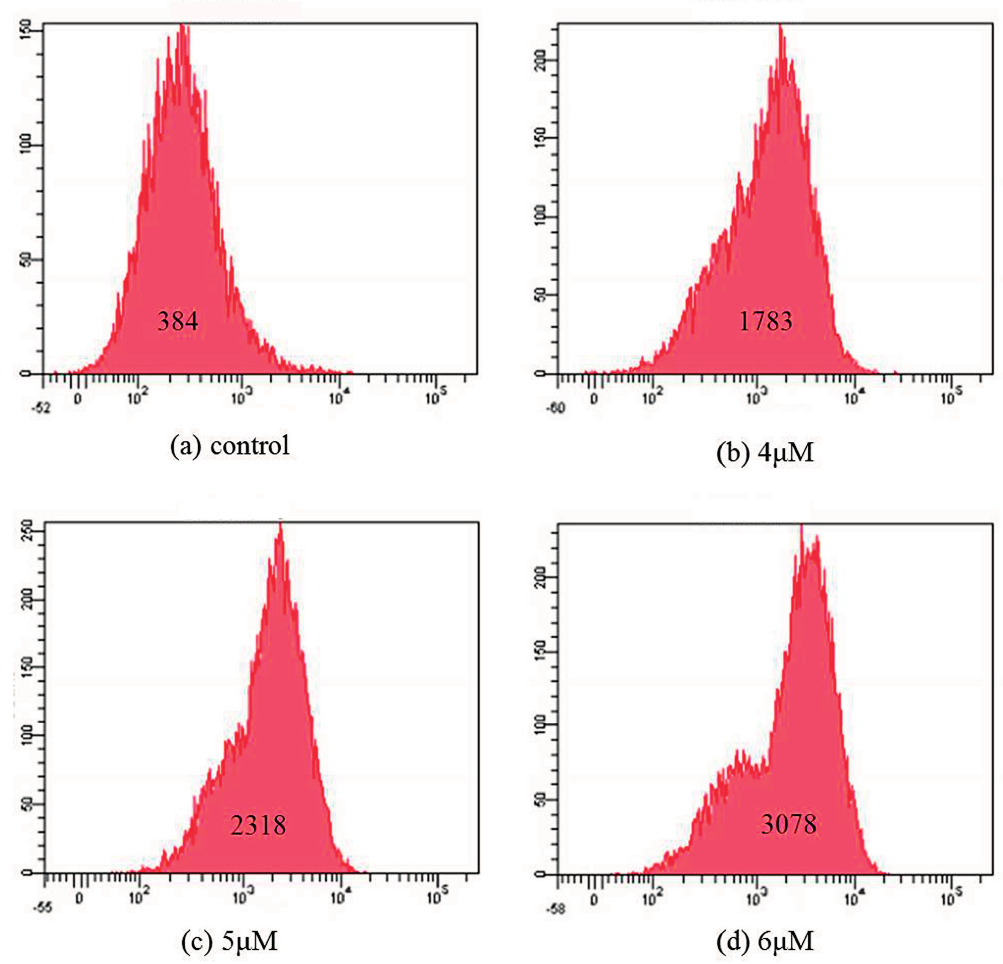
Figure 6. Mitochondrial membrane potential detection by Rhodamine 123 staining on the Bel-7402 cells treated by T-OA. ( a ) Control group without T-OA; ( b ) Treated with 5 µM T-OA; ( c ) Treated with 10 µM T-OA; and ( d ) Treated with 20 µM